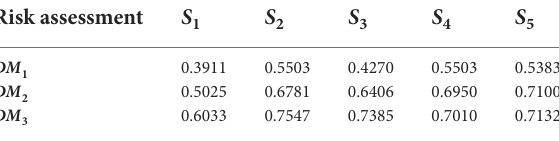
TABLE 12 Risk preference assessment of five alternatives for three decision makers. Risk assessment